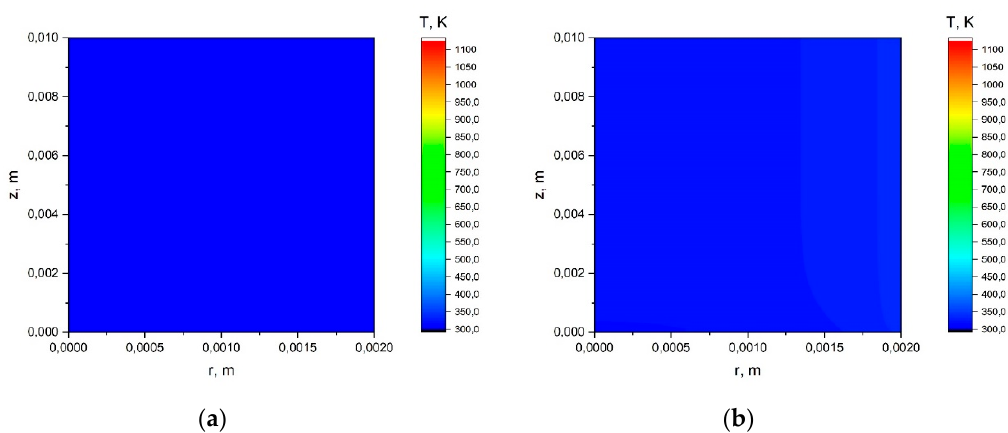
Figure 4. Temperature distribution in the stem of a herbaceous plant: R = 0.002 m, t = 6 s, q = 0.5 kW / m 2 ( a ); R = 0.002 m, t = 6 s, q = 3 kW / m 2 ( b ).